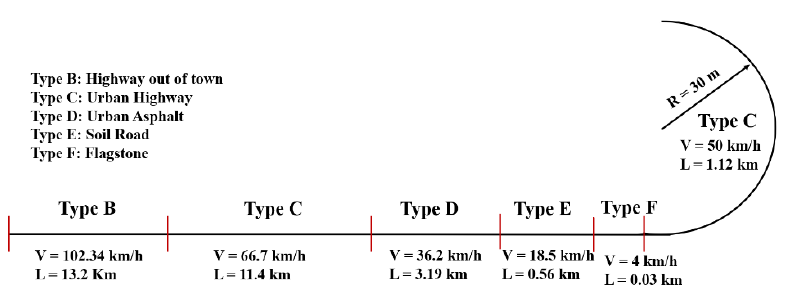
Figure 3. The details of equivalent road used in the MBD analysis.